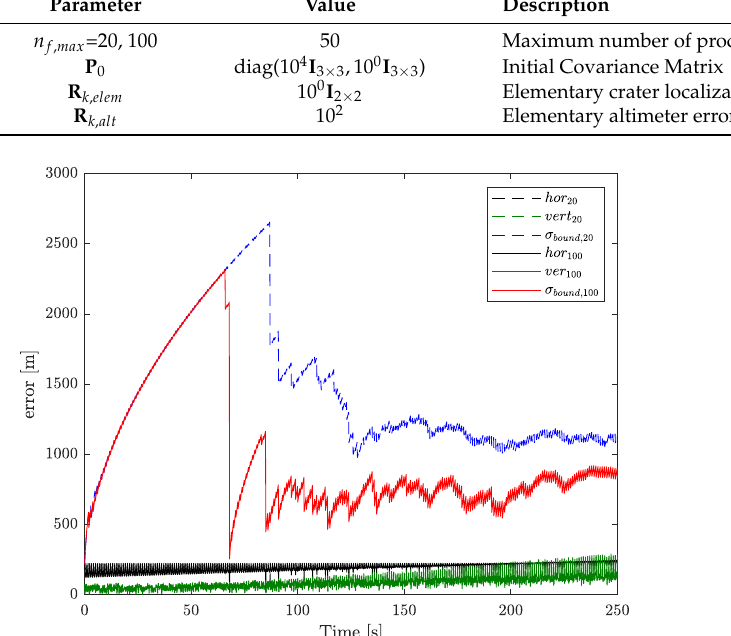
Figure 11. Numerical results for a sample landing trajectory with different maximum number of processed